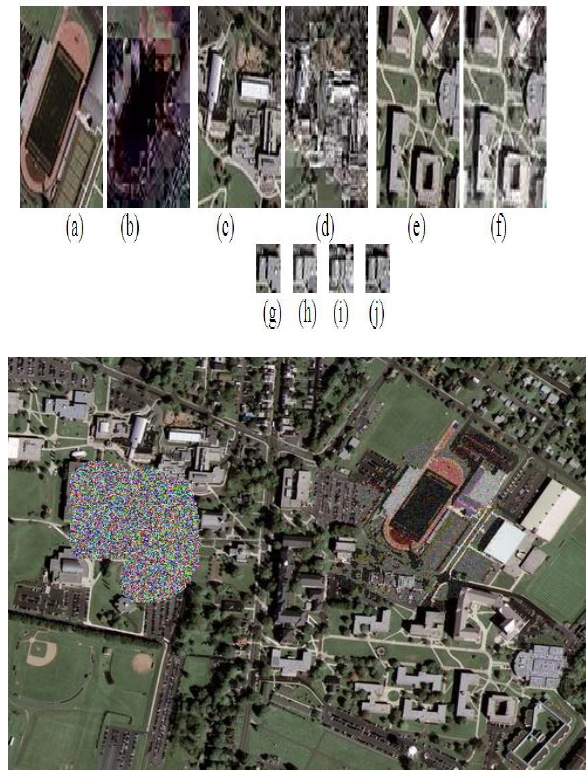
Figure 5. Results of multi-level region encryption images Multi-level authorization method by point, line, surface tool to select confidential area: We can select A, B ,C three areas of Fig.4 (confidential level A>B>C) to encrypt with different levels then publish as shown in Fig.6. From the processed images, it’s obviously that they have been damage to different degree. To area A, we can get no information from it. The resolution ratio of B and C decreased and B became worse. Then give out the image after processing to different users. High level users can get complete information of area A, B and C while the secondary users can obtain from B and C but A. what’s more, ordi nary users cannot encrypt any area.